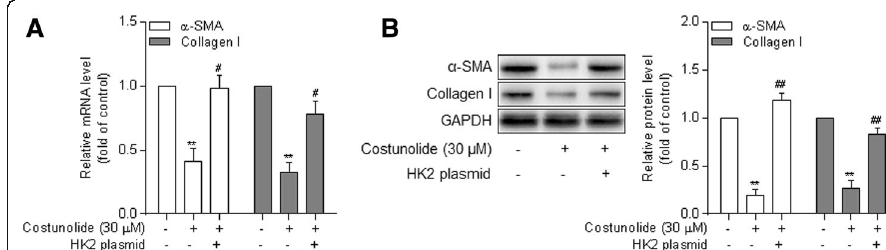
Fig. 5 Suppression of HK2 is required for costunolide inhibition of HSC. Primary rat HSCs at passages 3 through 5 were treated with costunolide at the indicated concentrations or transfected with HK2 overexpression plasmid for 24 h. a – Real-time PCR for determining the mRNA expression of α -SMA and collagen I. b – Western blot assay for determining the protein expression of α -SMA and collagen I with quantification of the blots. Statistics: ** p < 0.01 vs. control; # p < 0.05, ## p < 0.01 vs.